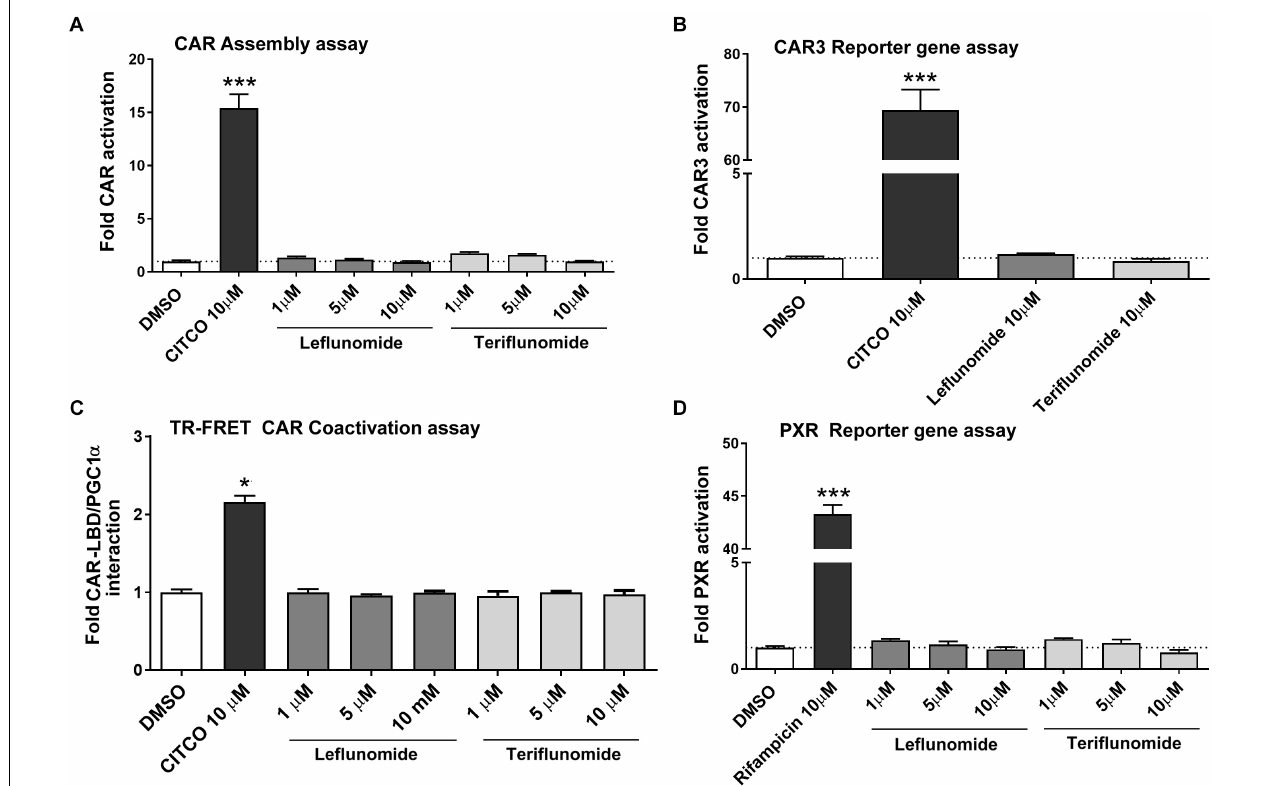
FIGURE 3 | Neither leflunomide nor teriflunomide directly activate hCAR and PXR. The CAR assembly assay (A) , CAR3 variant reporter gene assay (B) , TR-FRET CAR Coactivator assay (C) and PXR-sensitive luciferase reporter gene assay (D) were performed. Luciferase reporter gene assays were performed in HepG2 cells transiently transfected with either human CAR-N, CAR-C, CAR3 variant or human PXR expression plasmids and appropriate responsive luciferase reporter promoter constructs (pGL5-luc, p2B6-luc, p3A4-luc) together with Renilla expression construct for transfection normalization (see section Materials and Methods). HepG2 cells were treated with LEF or TER (1, 5, or 10 µ M) together with CITCO (10 µ M) and rifampicin (10 µ M), respectively, for 24 h. Relative activation was calculated relative to vehicle-treated samples (DMSO 0.1%) and data are presented as the means ± SD from three independent experiments ( n = 3) performed in triplicates. (C) The LanthaScreen R (cid:13) TR-FRET CAR coactivator binding assay was employed to determine interactions of tested compounds with the hCAR-LBD. The manufacturer’s protocol was followed with several modifications described in section Materials and Methods. Data are presented as the relative fold interaction between hCAR-LBD and PGC1 α fragment to the control (DMSO-treated) samples, set to 1. Data indicate the mean ± SD of three independent assays ( n = 3) performed in quadruplicates. ∗ P < 0.05, ∗∗∗ P < 0.001 – statistically significant difference compared to the control (DMSO-treated) cells.